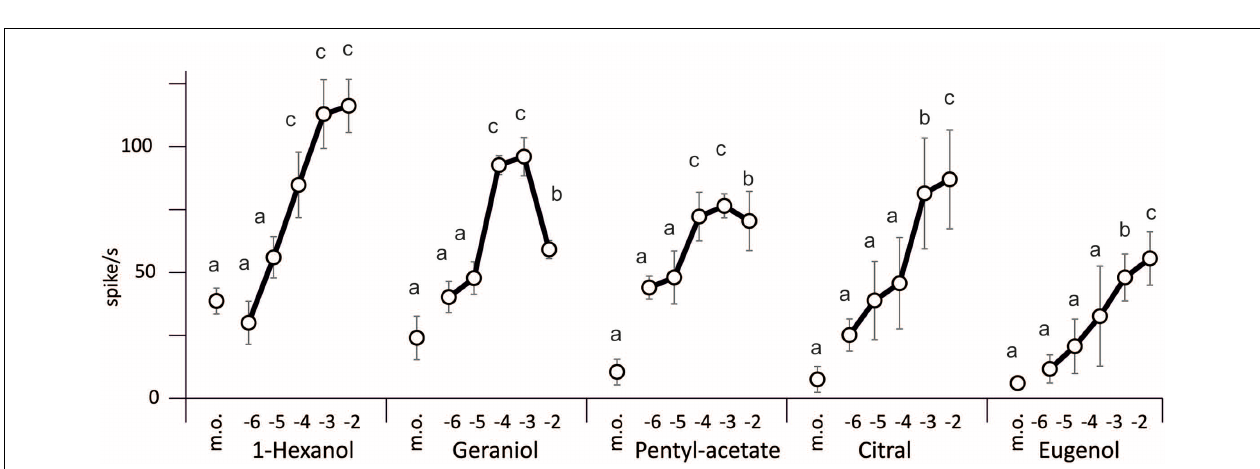
the number of spikes emitted during the 500ms stimulus minus the number of spikes elicited over the 500ms period before the stimulus ( n = 8–12 caterpillars, 1 stimulation per caterpillar). All the results were compared to the control using a Student’s t -test with Bonferroni